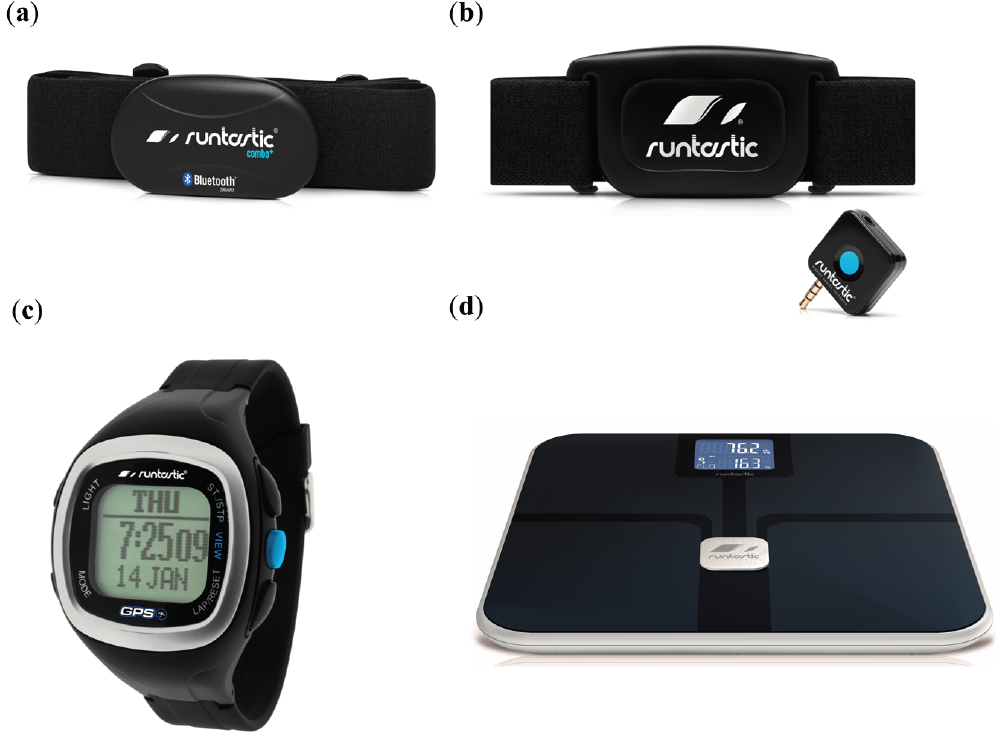
Figure 7. SBD developed by Runtastic GmbH. ( a ) The Bluetooth low-energy chest strap of the Runtastic Heart Rate Combo Monitor; ( b ) chest strap and dongle of the Runtastic Heart Rate Monitor; ( c ) Runtastic GPS Watch; ( d ) Runtastic LIBRA weighing scale. Images provided by Johannes Knoll, Runtastic